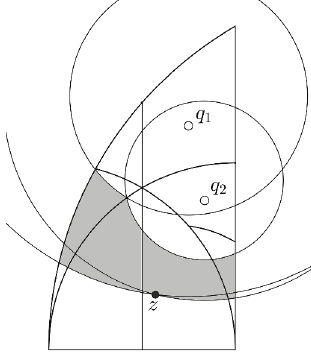
Figure 13. Compact set K such that for u ∈ K , d ( u,q 1 ) ≤ d ( z,q 1 ) or d ( u,q 2 ) ≤ d ( z,q 2 ) , and at the same time r + ε ≤ d ( u,q 1 ) and r + ε ≤ d ( u,q 2 )